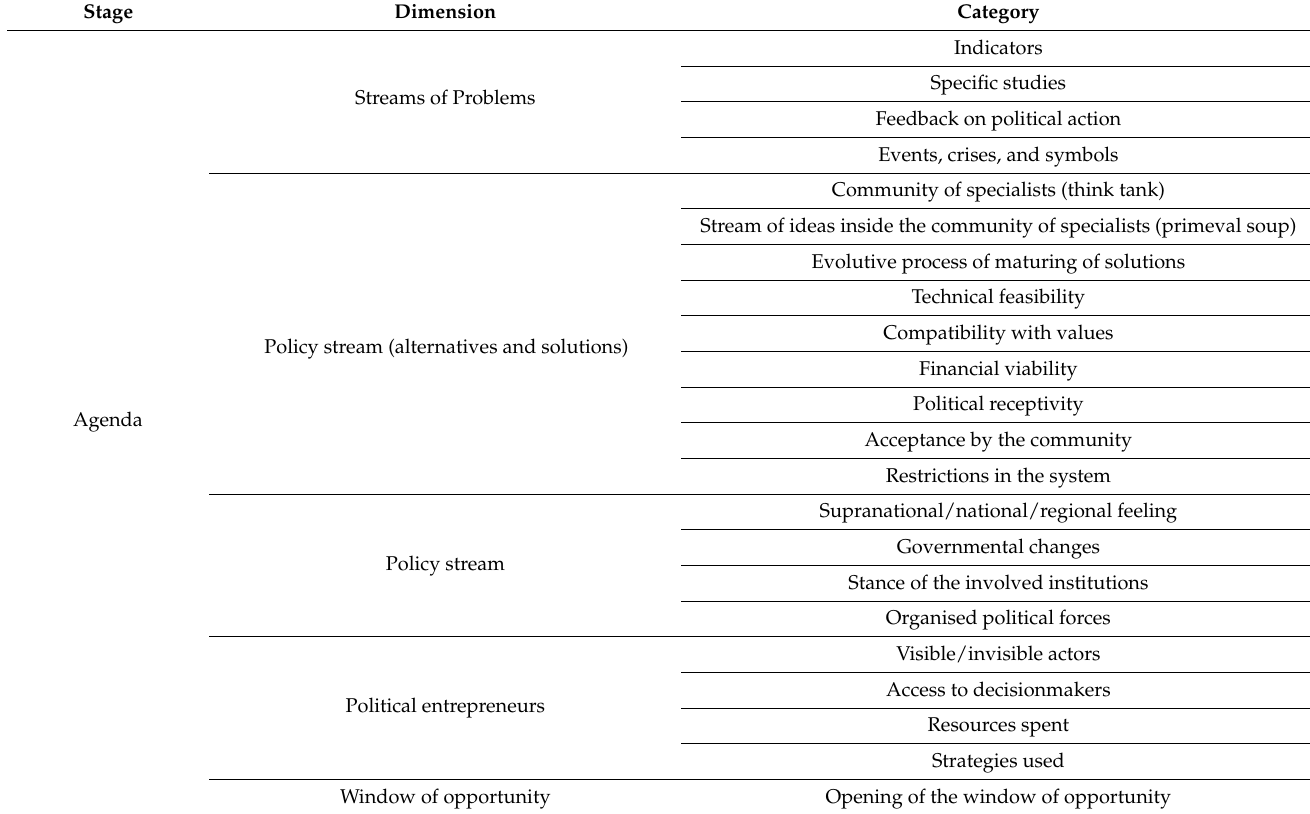
Table 1. Dimensions and categories of the agenda stage.